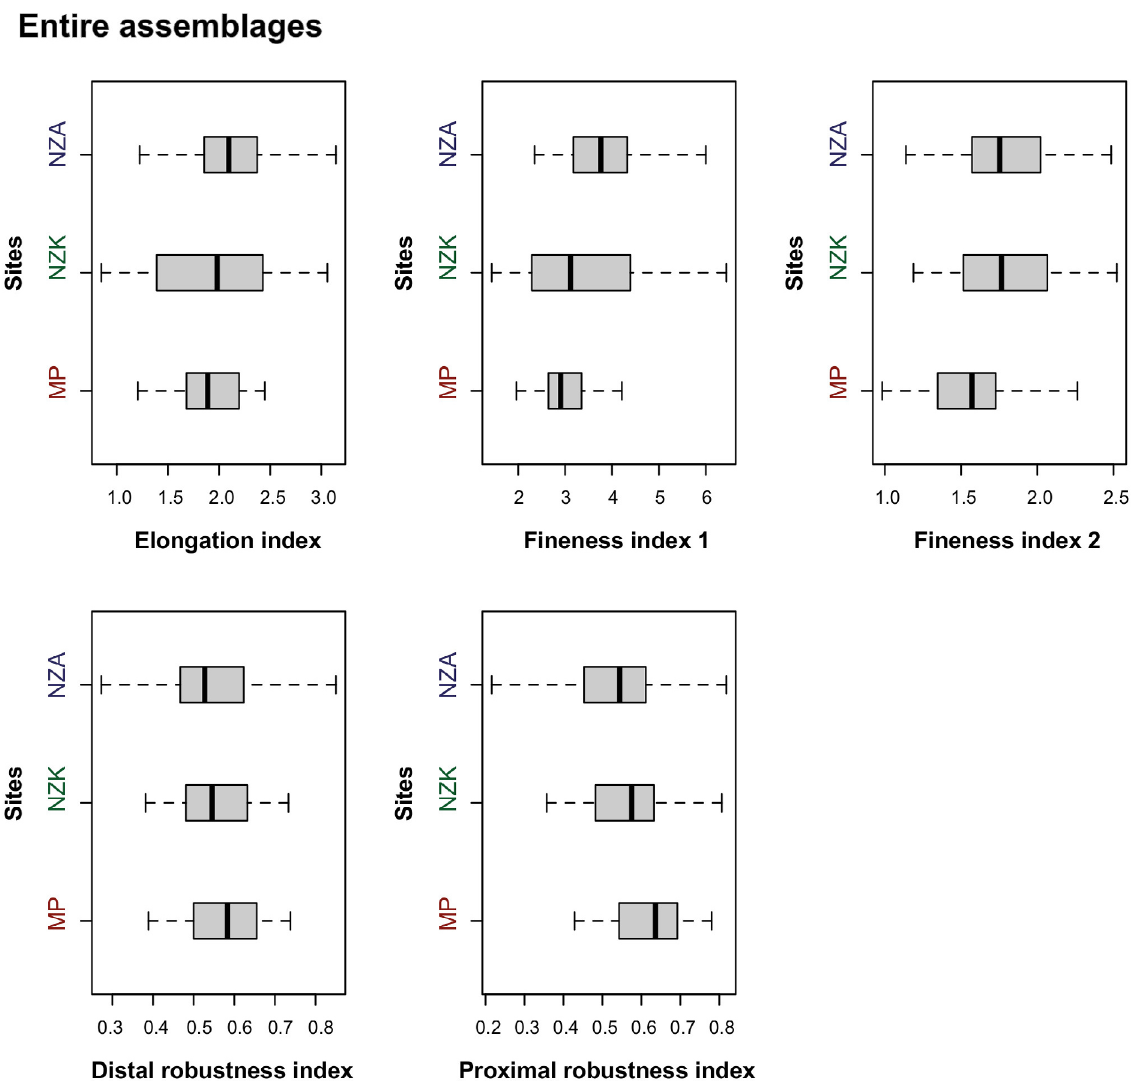
Figure 9. Boxplots for indices and sites, integrating the whole bifacial shaped tools assemblages. (Elongation index: NZA X̅ =2.149, sd=0.4568131, NZK X̅ =1.9488, sd=0.6461972, MP X̅ =1.892, sd=0.3660371, Fineness index 1: NZA X̅ =3.889, sd=1.026811, NZK X̅ =3.476, sd=1.349903, MP X̅ =2.897, sd=0.7903313,